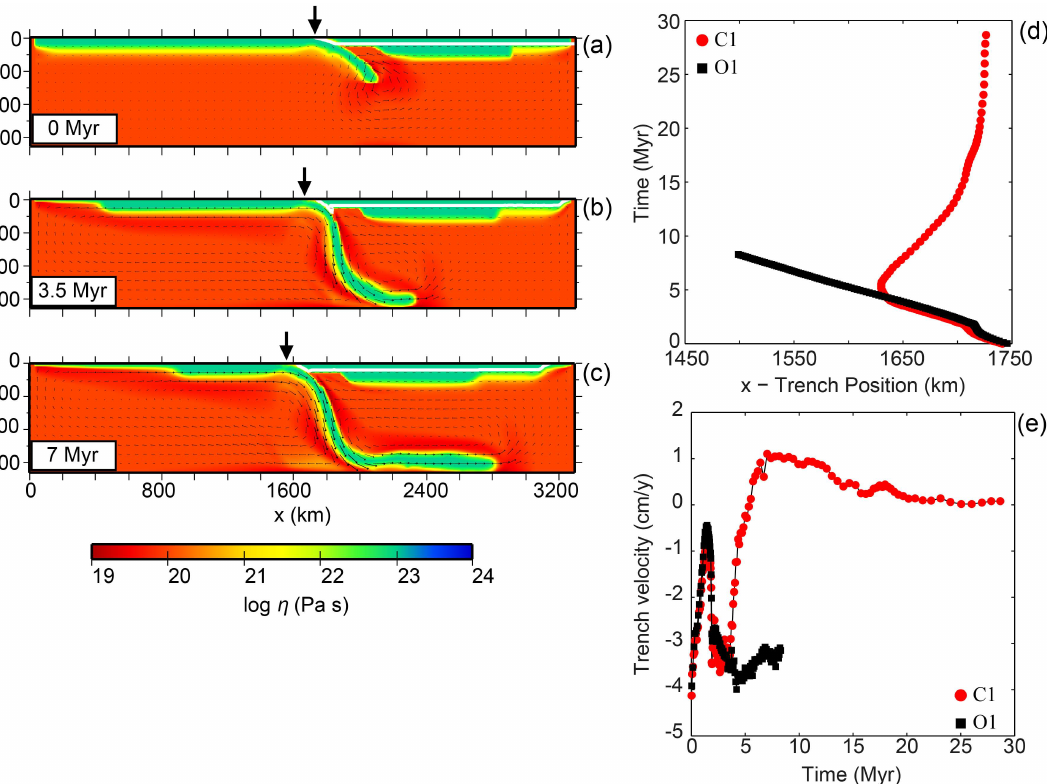
Fig. 4. (a-b-c) Viscosity plots of purely oceanic subducting plate model O1; arrows show the velocity field. Thick arrows indicate the trench position at each time step. Comparison between model C1 (red dots) and O1 (blue squares): (d) Trench migration and (e) trench velocity (negative velocity indicates trench retreating) during model